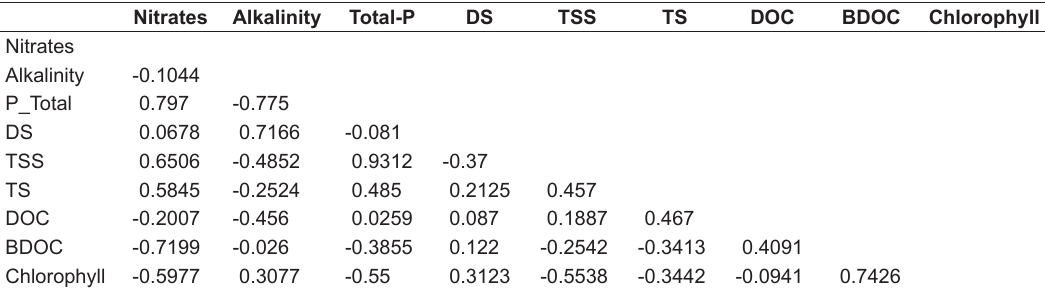
Table 4. Correlation matrix of the physicochemical variables studied in Hidrosogamoso during the first year after impoundment. Variables: Nitrates, Alkalinity, Total Phosphorous (P_Total), Dissolved Solids (DS), Total Suspended Solids (TSS), Total Solids (TS), Dissolved Organic Carbon (DOC), Biodegradable Dissolved Organic Carbon (BDOC) and